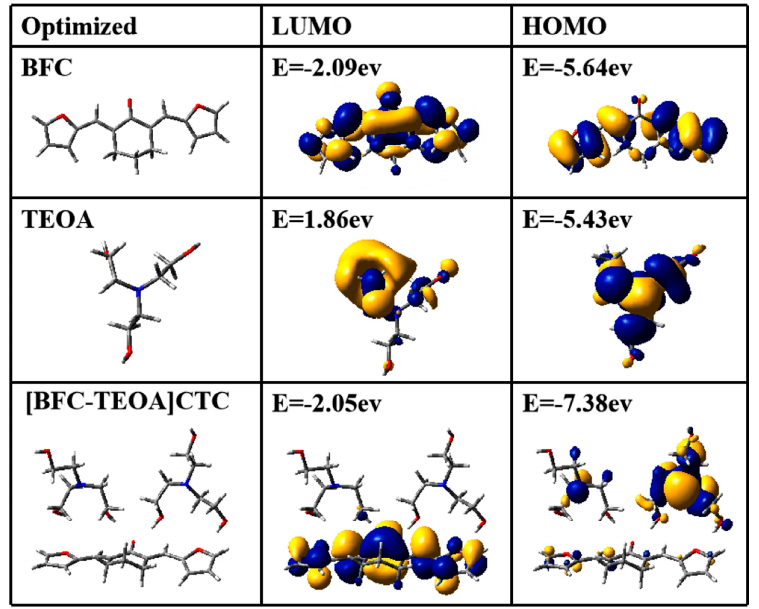
Figure 12. Contour plots of the HOMO and LUMO energy levels of BFC, TEOA, and [BFC/TEOA] CTC . Reproduced with permission of Ref. [167] .